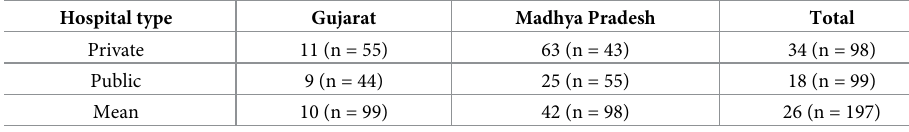
Table 3. Incidence of OOP payments during hospitalization